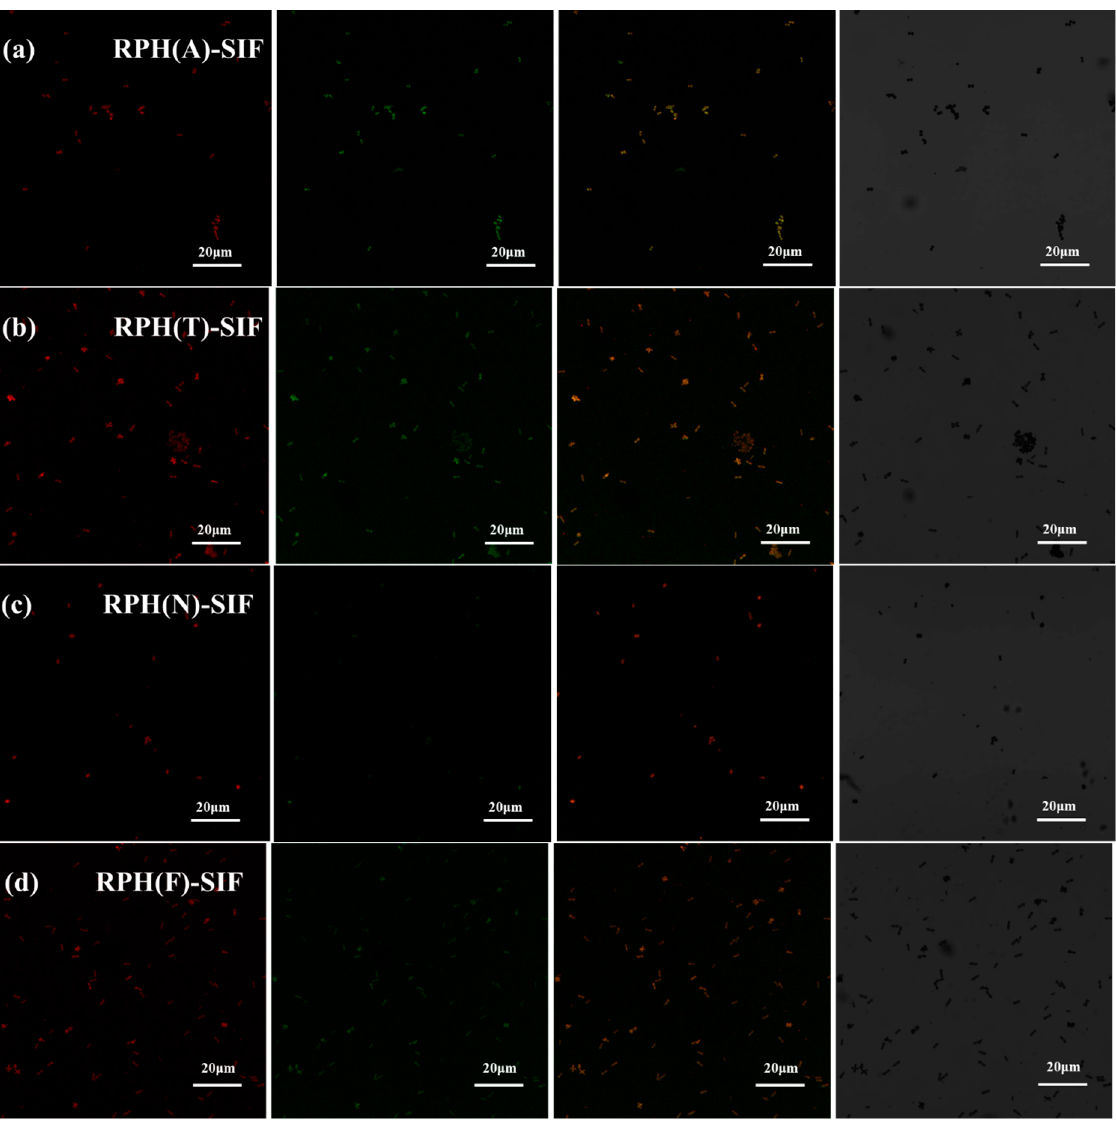
Figure 3. The CLSM images of RPH(A)-SIF ( a ), RPH(T)-SIF ( b ), RPH(N)-SIF ( c ), and RPH(F)-SIF ( d ). Red and green represented RPHs and SIF, respectively.